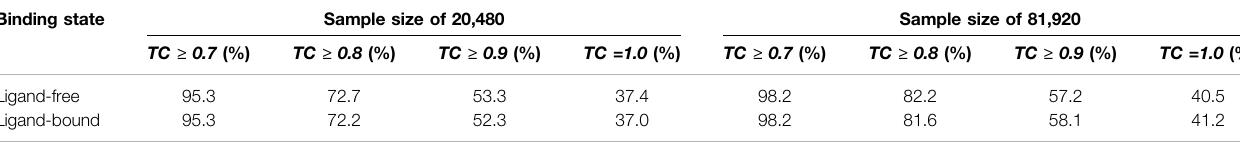
TABLE2| HitratesforthePocket2Drug-apodataset.Foreachligand-freestructure,thecorrespondingligand-boundpocketisselectedfromthePocket2Drug-holodataset for the apples-to-apples comparison. Binding state